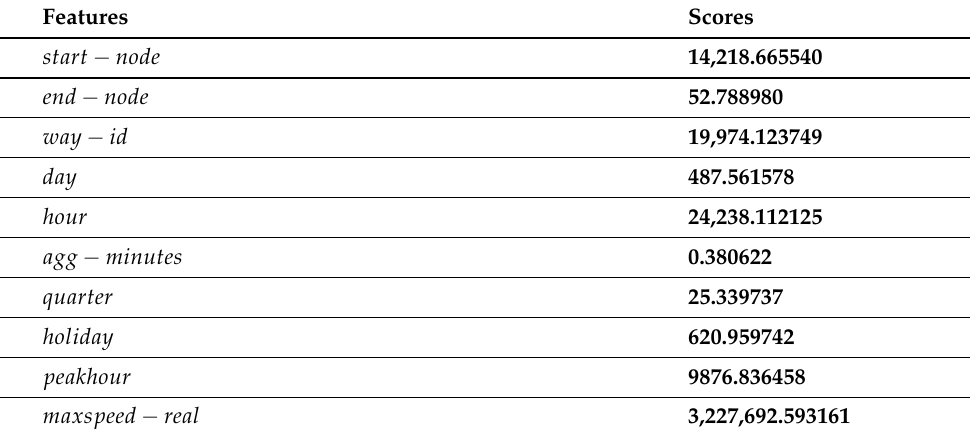
Table 3. Feature selection through correlation feature selection